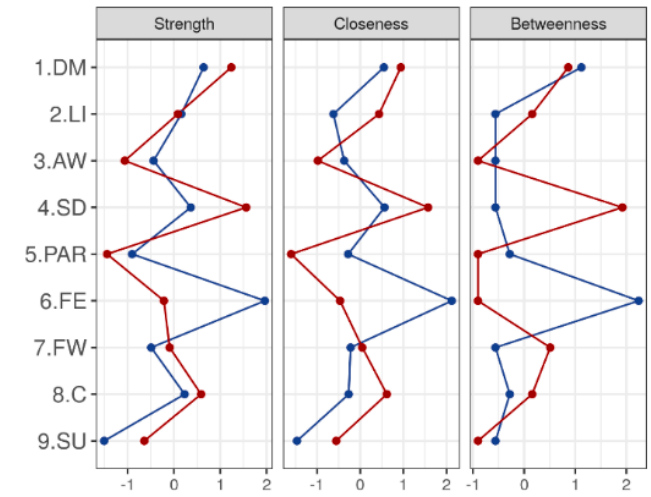
Figure 4. Centrality measures for CIDI65 + items by age groups. DM: depressed mood; LI: loss of interest or pleasure; AW: appetite or weight disturbance; SD: sleep di ffi culties (insomnia or hypersomnia); PAR: psychomotor agitation or retardation; FE: fatigue or loss of energy; FW: feelings of worthlessness or guilt; C: diminished ability to think or concentrate; SU: suicidality; measures of centrality on CIDI65 + for age groups. The figure shows a plot of standardized values. The 65–74 age group is represented by the blue line, and the 75–84 group by the red line. Table 4. Centrality measures for CIDI65 + items by age groups.